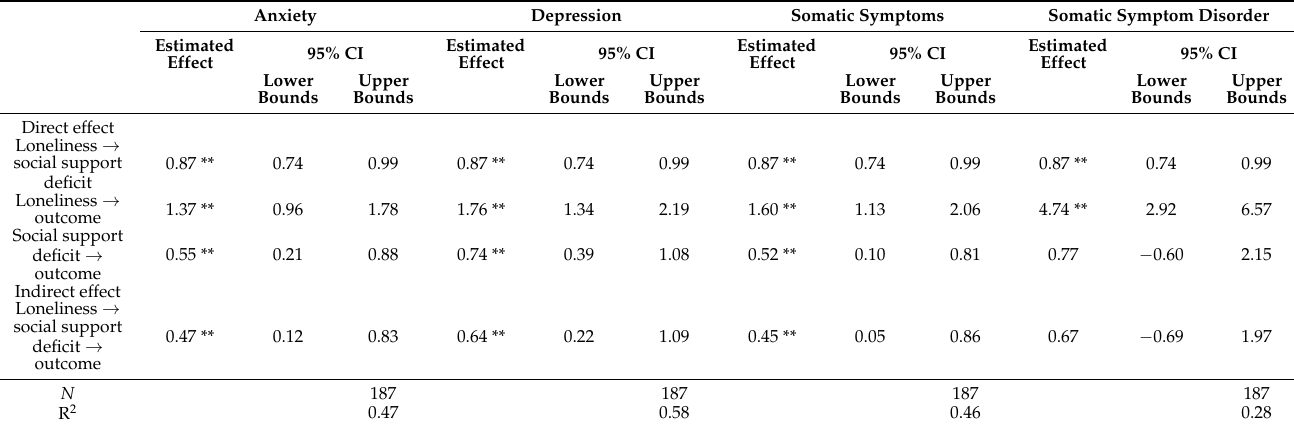
Table 2. Direct and indirect effects and 95% confidence intervals for the mediation analyses before inclusion of the covariates.